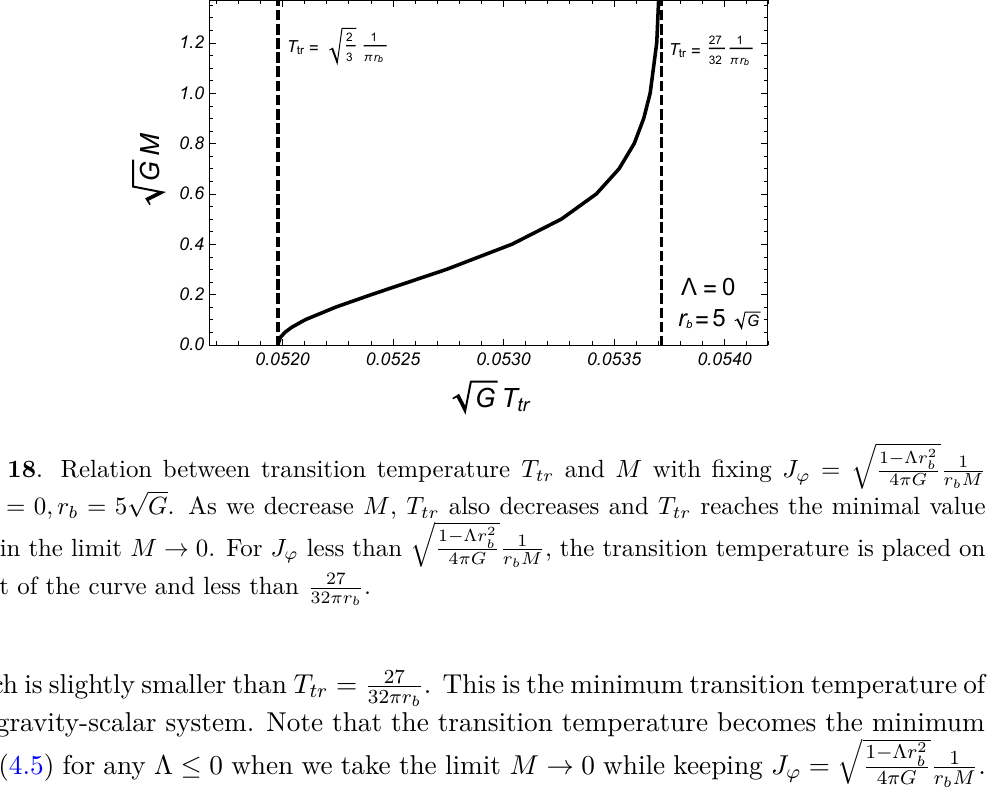
q 1 − Λ r 2 less than , the transition temperature is placed on 1 b ϕ 4 πG r b M 27 32 πr b